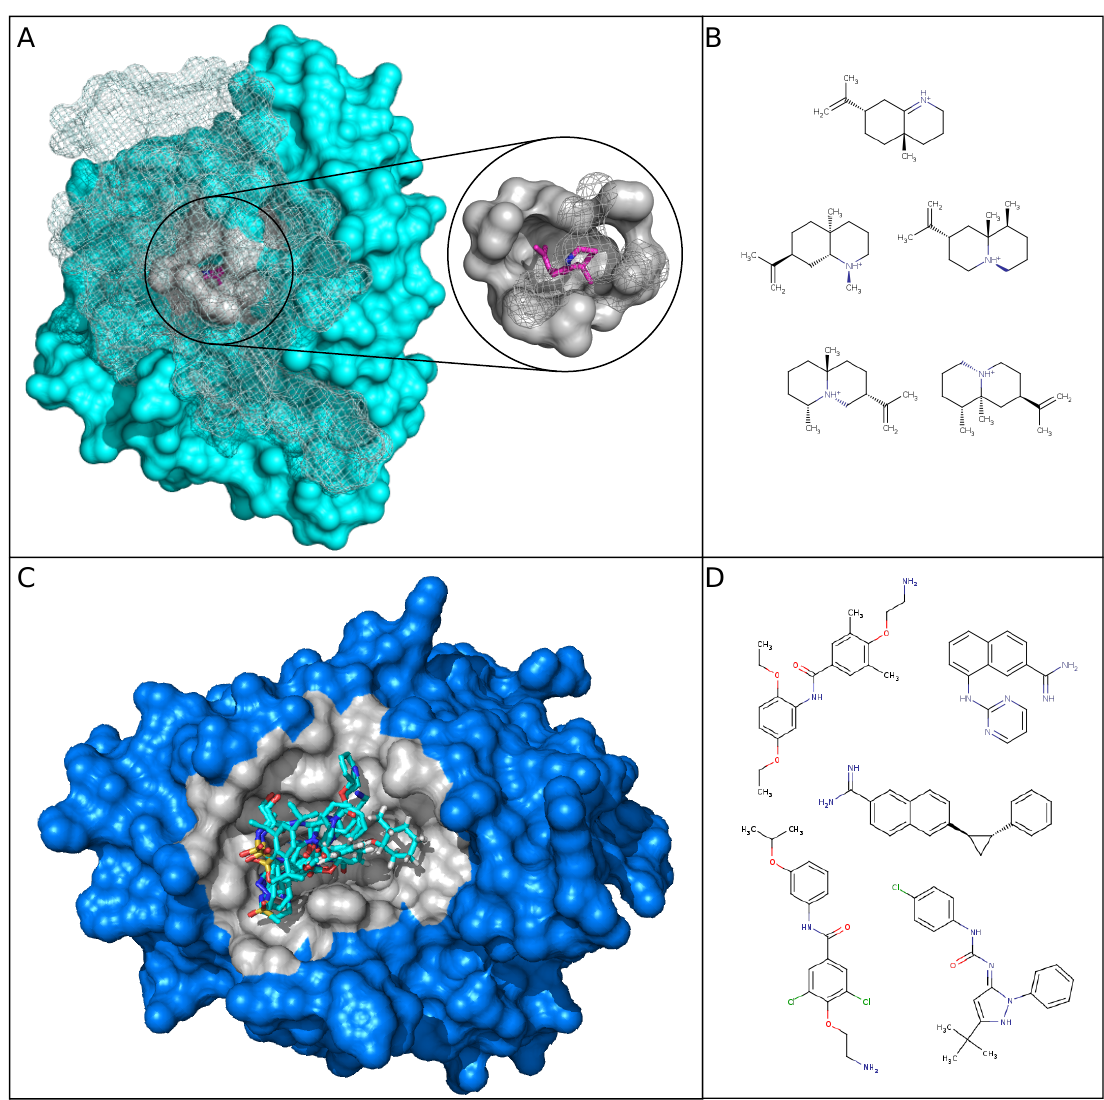
Figure 5. Illustration of one selective and one HP DBS and some of their associated ligands. ( A ) The aristolochene synthase protein with a selective DBS is represented in cyan with its representative structure: a lyase from Aspergillus terreus (PDB 4KVI, Pocket-Cluster no. 141_1). The grey part (in the surface and mesh) is the pocket that interacts with the ligand, where the carbon is represented by pink and the nitrogen in blue (PDB 1SV, Ligand–Cluster 300). Part of the protein and pocket are represented in mesh instead of the surface to facilitate the visualization of the pocket buried in the three-dimensional (3D) protein. ( B ) Five ligand two-dimensional (2D) structures (Tanimoto > 0.8) from the Ligand–Cluster associated with the selective DBS. ( C ) The human urokinase plasminogen activator protein with a HP DBS is represented in blue with its representative structure: a hydrolase from Homo sapiens (PDB 1F5K, Pocket-Cluster no. 94_2). Its pockets are represented in grey and five representatives of the 17 di ff erent Ligand–Clusters that can bind to the DBS (carbon in cyan, nitrogen in blue, oxygen in red, and sulfur in orange). ( D ) Five ligand structures in two-dimensional (2D) (Tanimoto < 0.8) among the 17 di ff erent Ligand–Clusters that can bind to the HP DBS. Structures were visualized using PyMOL